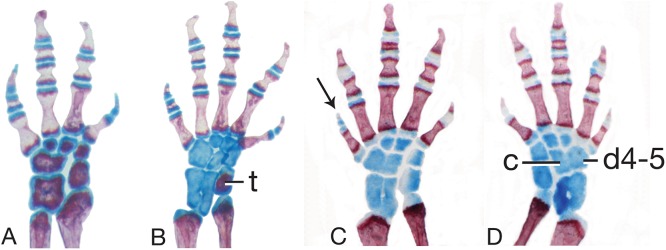
Limb skeletal morphology and variation.(A) The left hand of MVZ 186837, Thorius longicaudus, displays carpal (wrist) pattern I, the predominant pattern in the genus, including all five species considered in the present study. (B) The left foot of MVZ 186824, T. longicaudus, displays tarsal (ankle) pattern I, which predominates in this species as well as in T. pinicola, T. tlaxiacus and T. narisovalis. (C, D) Left and right feet of IBH 23012, T. minutissimus, show bilateral asymmetry in tarsal pattern (V and VII, respectively). Distal tarsal 4–5 (d4–5) and the centrale (c) are fused in VII; they are separate, but overlapping, in V. Both patterns are otherwise rare in the genus. Note also the different phalangeal formulae between B (1-2-3-3-2) and C and D (1-2-3-2-1), which have a correspondingly short fifth toe (arrow). Cartilaginous (blue) tarsals and metatarsals in C and D indicate a subadult specimen. Cartilage is beginning to ossify in B (t, tibiale; red) and wrist elements are nearly fully ossified in A, indicating the onset of sexual maturity in these specimens. All limbs are shown in dorsal view.